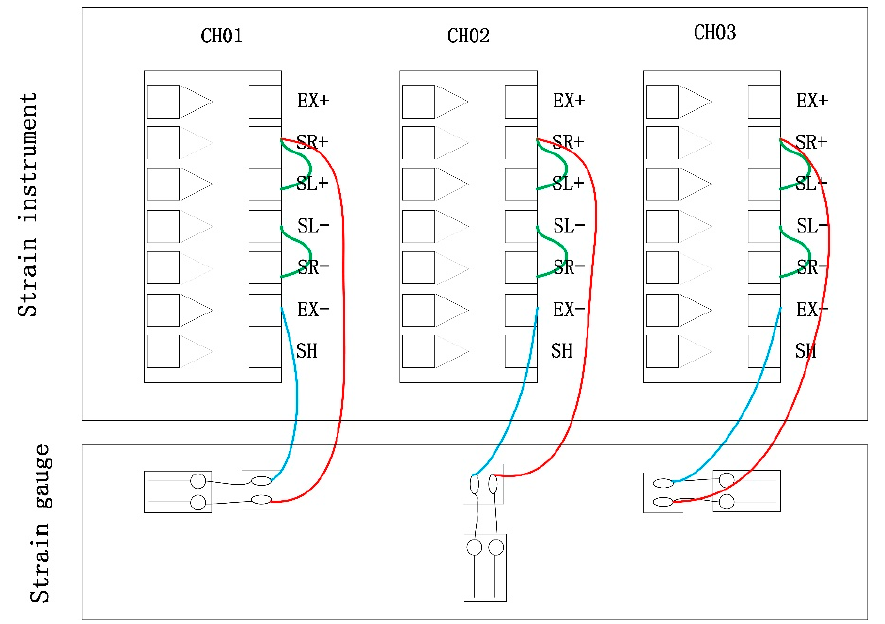
Figure 4. Half ‐ bridge one ‐ to ‐ one compensation strain measurement wiring diagram. Figure 4. Half-bridge one-to-one compensation strain measurement wiring